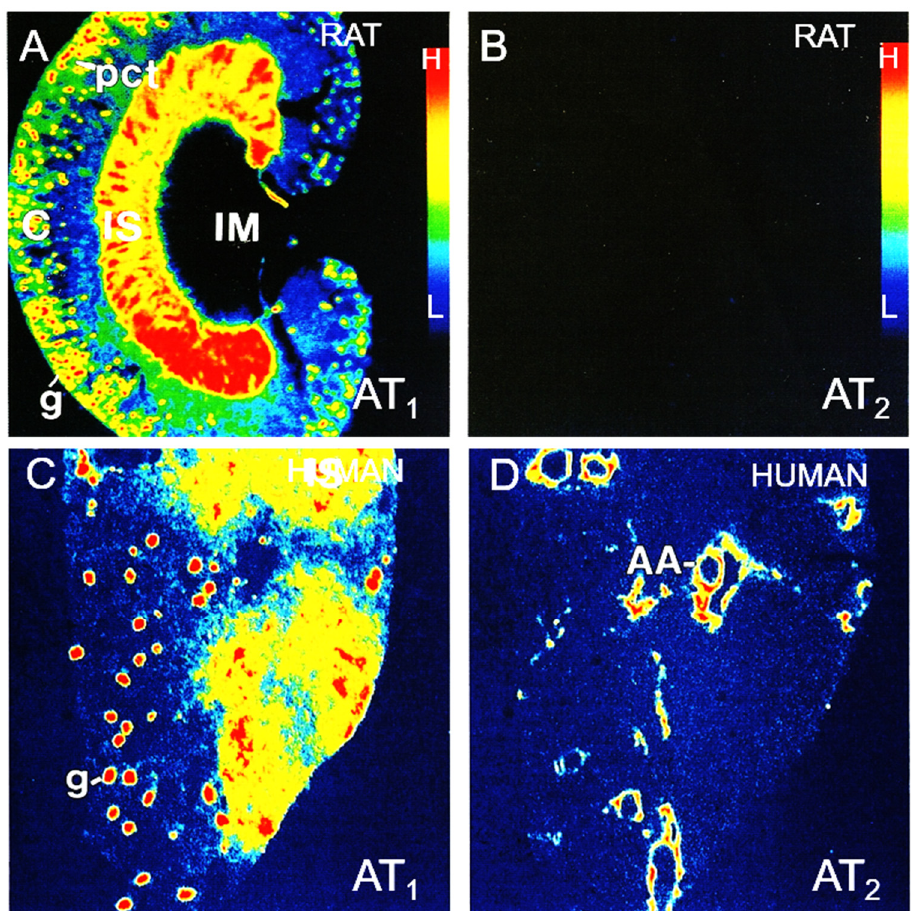
Figure 1. Localization of angiotensin II AT 1 and AT 2 receptors in the rat ( A , B ) and human kidney ( C , D ) by quantitative in vitro autoradiography using radiolabeled [ 125 I]-angiotensin II as a ligand. AT 1 receptor binding is defined as [ 125 I]-angiotensin II binding in the presence of an excess concentration of unlabeled AT 2 receptor blocker PD123319 (10 µM), whereas AT 2 receptor binding is defined as [ 125 I]-angiotensin II binding in the presence of an excess concentration of unlabeled AT 1 receptor blocker losartan (10 µM), respectively. Red represents the highest level of binding, whereas blue represents the background level of binding. C, cortex; IS, inner stripe of the outer medulla; IM, inner medulla; AA, blood vessels including afferent and efferent arterioles and interlobular arteries; g, glomerulus; pct, proximal convoluted tubule. Modified from References [46–48].